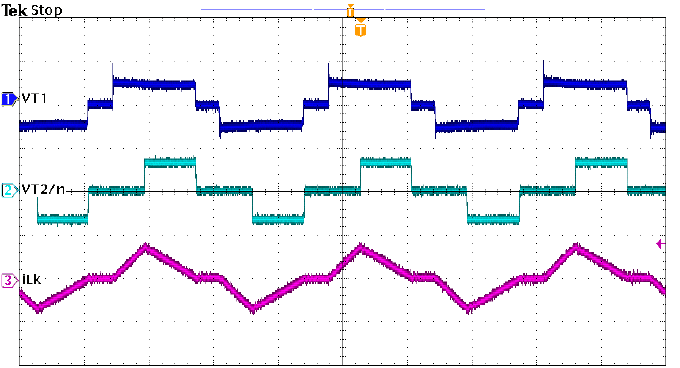
Figure 10. High-frequency signals. From top to bottom, voltage V T1 (250 V/div), voltage V T2 /n (250 V/div), and series inductance current (10 A/div).